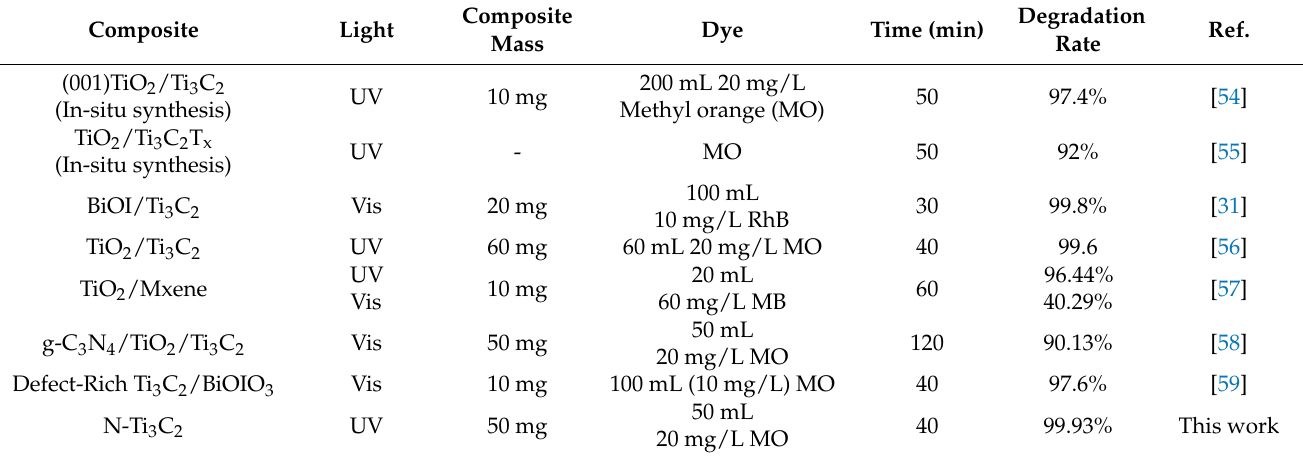
Figure 8. Effect of dye concentration on degradation rate. Table 1. Represents the photo-catalytic activity of 2D material-based composite catalysts.